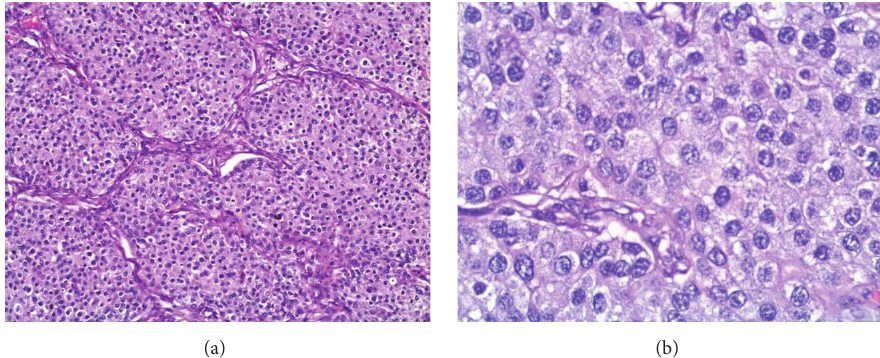
Figure 1: Lymph node with metastasis: (a) uniform cells, growing in solid nests, with eosinophilic cytoplasm and stippled chromatin X & @ , × 40; (b) “salt and pepper” chromatin X & @ , × 100.